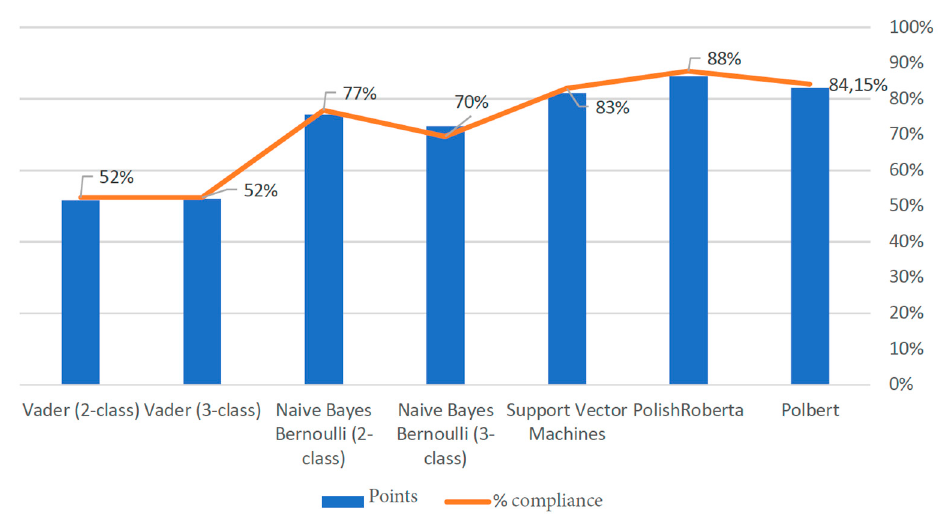
Figure 3. Test of sentiment research methods for Polish comments without those considered neu- tral.